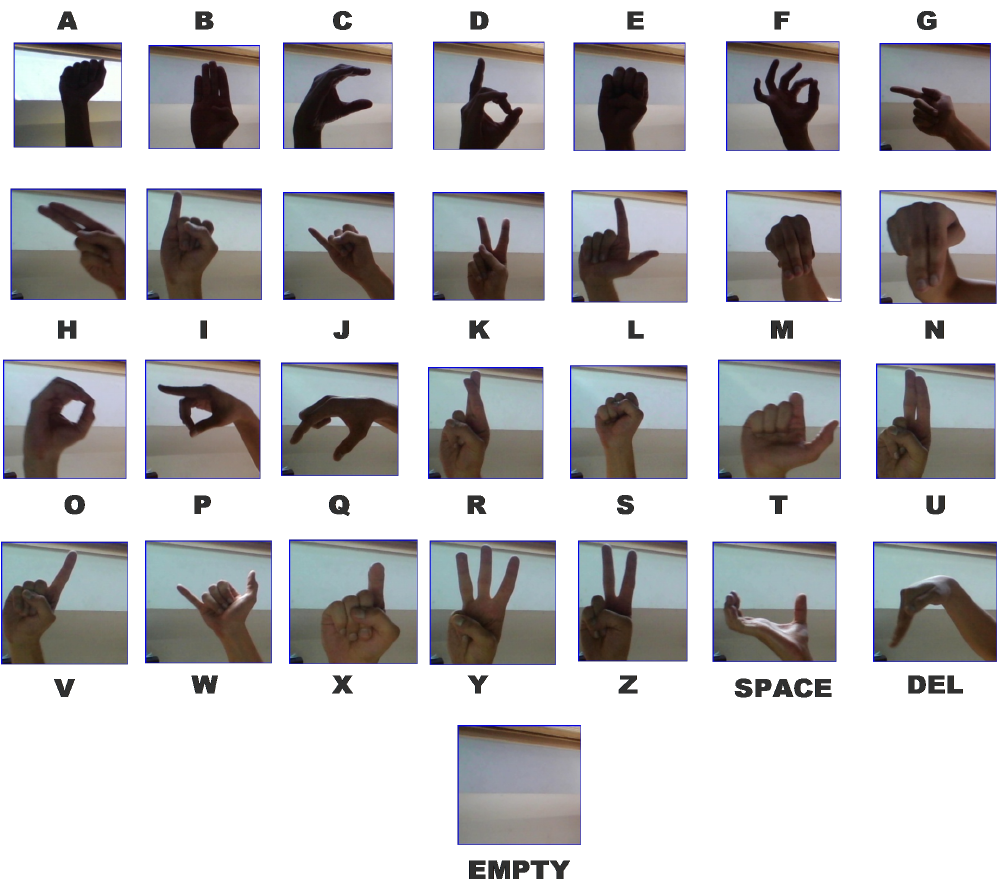
Figure 8. English ASL alphabet based hand gesture dataset. Here, the first 26 (Twenty six) gesture represents from A to Z; 3 extra gesture classes for SPACE, DELETE, and